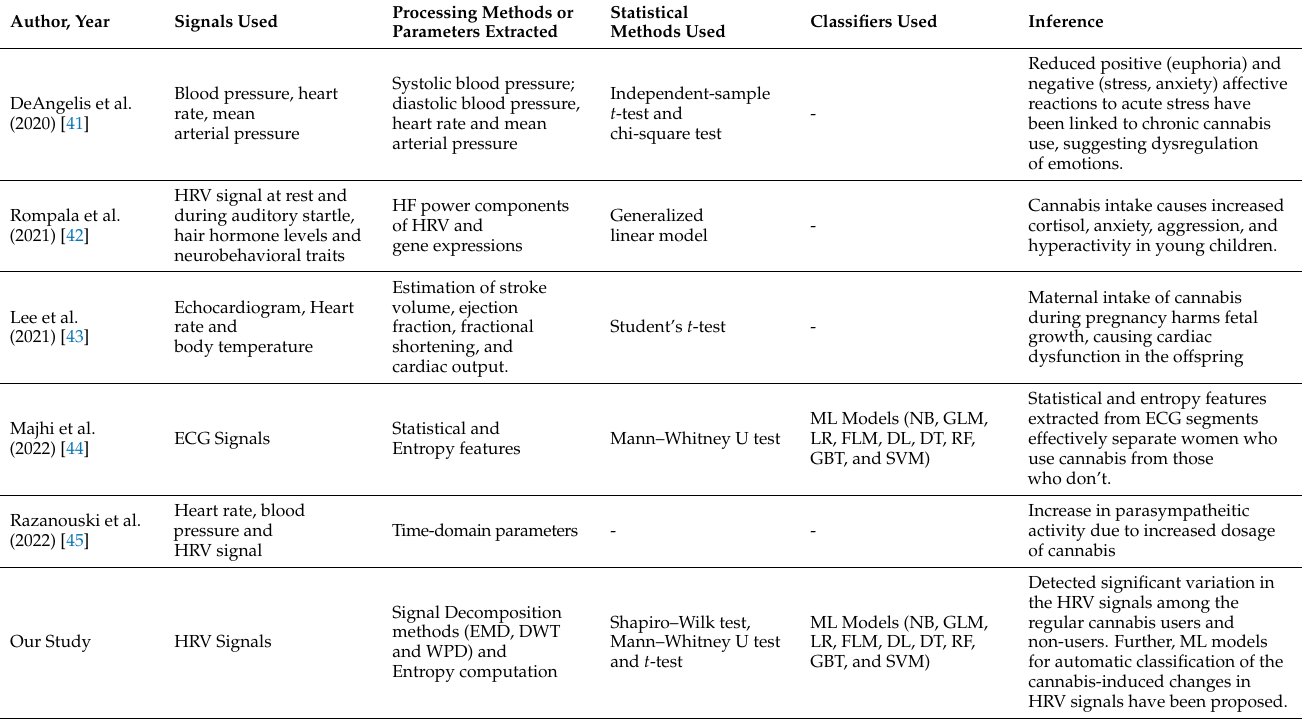
Table 7. Recent studies on the effects of cannabis on cardiovascular